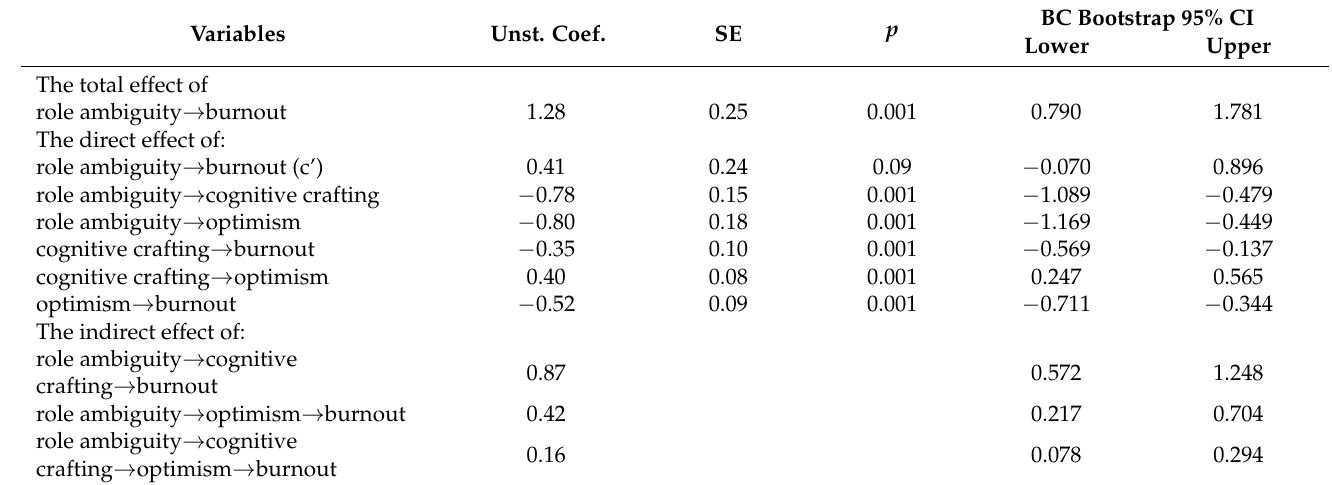
Table 4. Total, direct, and indirect effects of the mediation model 2—role ambiguity on burnout through cognitive crafting and optimism